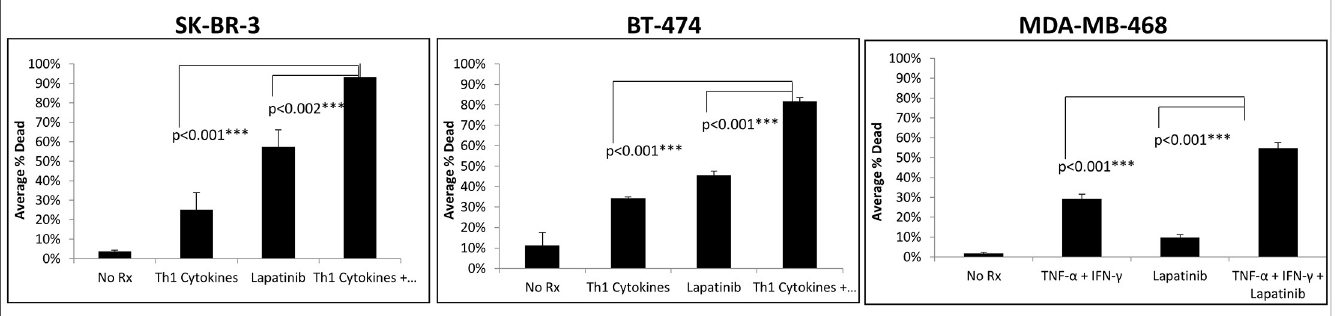
Fig 2. Lapatinib works in conjunction with Th1 cytokines to increase percentage of non-viable cells. Cultured SK-BR-3, BT-474 and MDA-MB-468 cells were treated either with Th1 cytokines (TNF- α plus IFN- γ ; 20 and12.5ng/ml respectively), Lapatinib (200nM), Lapatinib plus Th1 cytokines or left untreated (control). After 72 hours, cells were harvested, stained with Trypan Blue dye and percentage of viable and non-viable cells enumerated microscopically with the aid of a hemocytometer. Shown are composite data from three independent experiments with each cell line expressed as the percentage stained (i.e. non-viable) cells of total cells counted. Statistical significance was determined by one-way ANOVA on percent dead followed by the Holm-Sidak multiple comparison